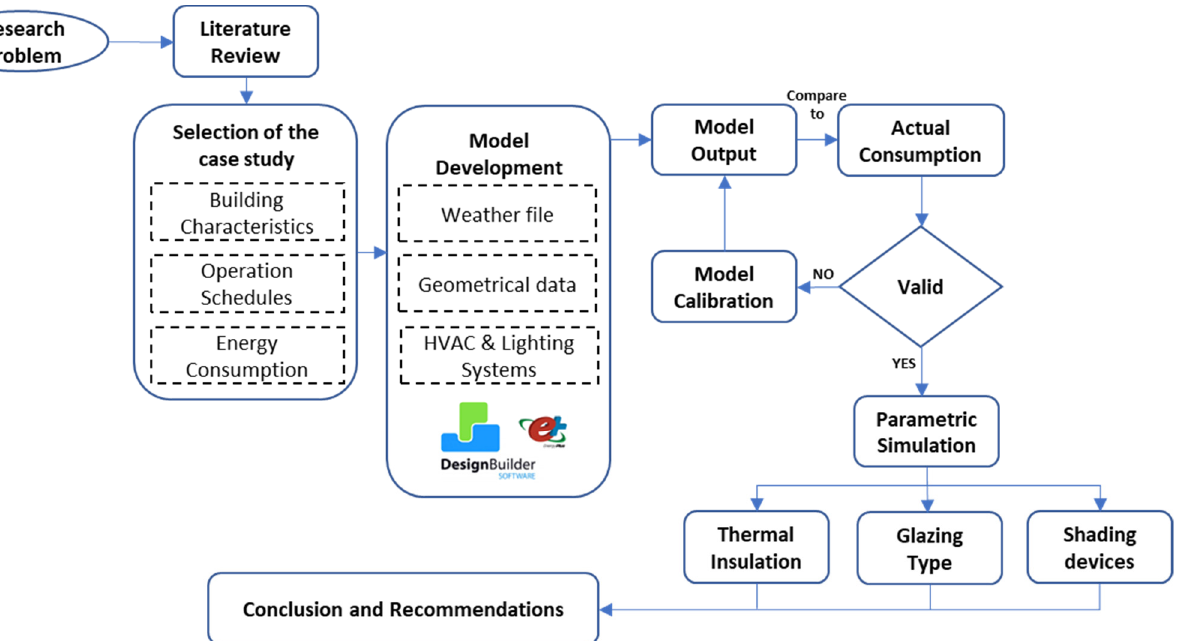
Table 1. Climate characteristics of selected location [26]. Location